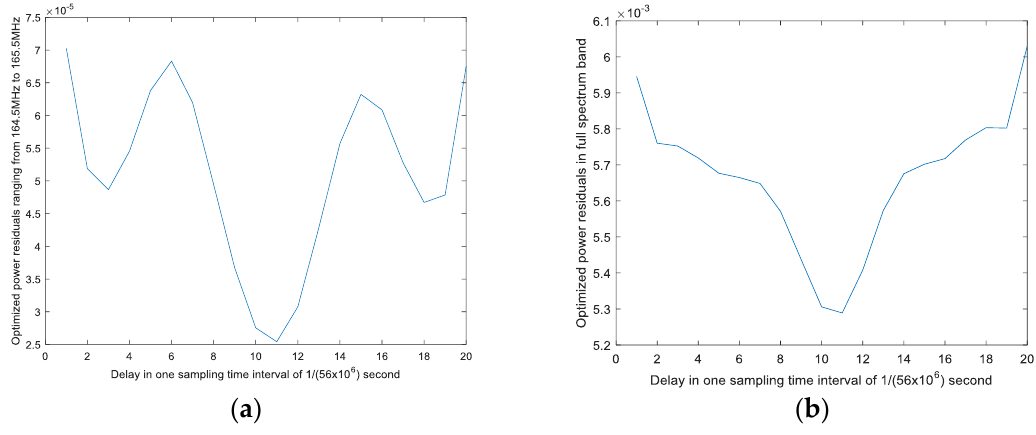
Figure 8. Relationships between delay and power residuals after optimization: ( a ) the optimized power residuals in the false-alarm region; and ( b ) the optimized power residuals in the full-spectrum band. Sensors 2017 , 17 , 2233